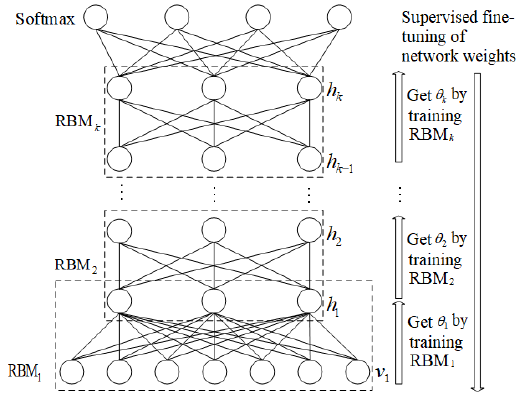
Figure 1. Structure of DBN.